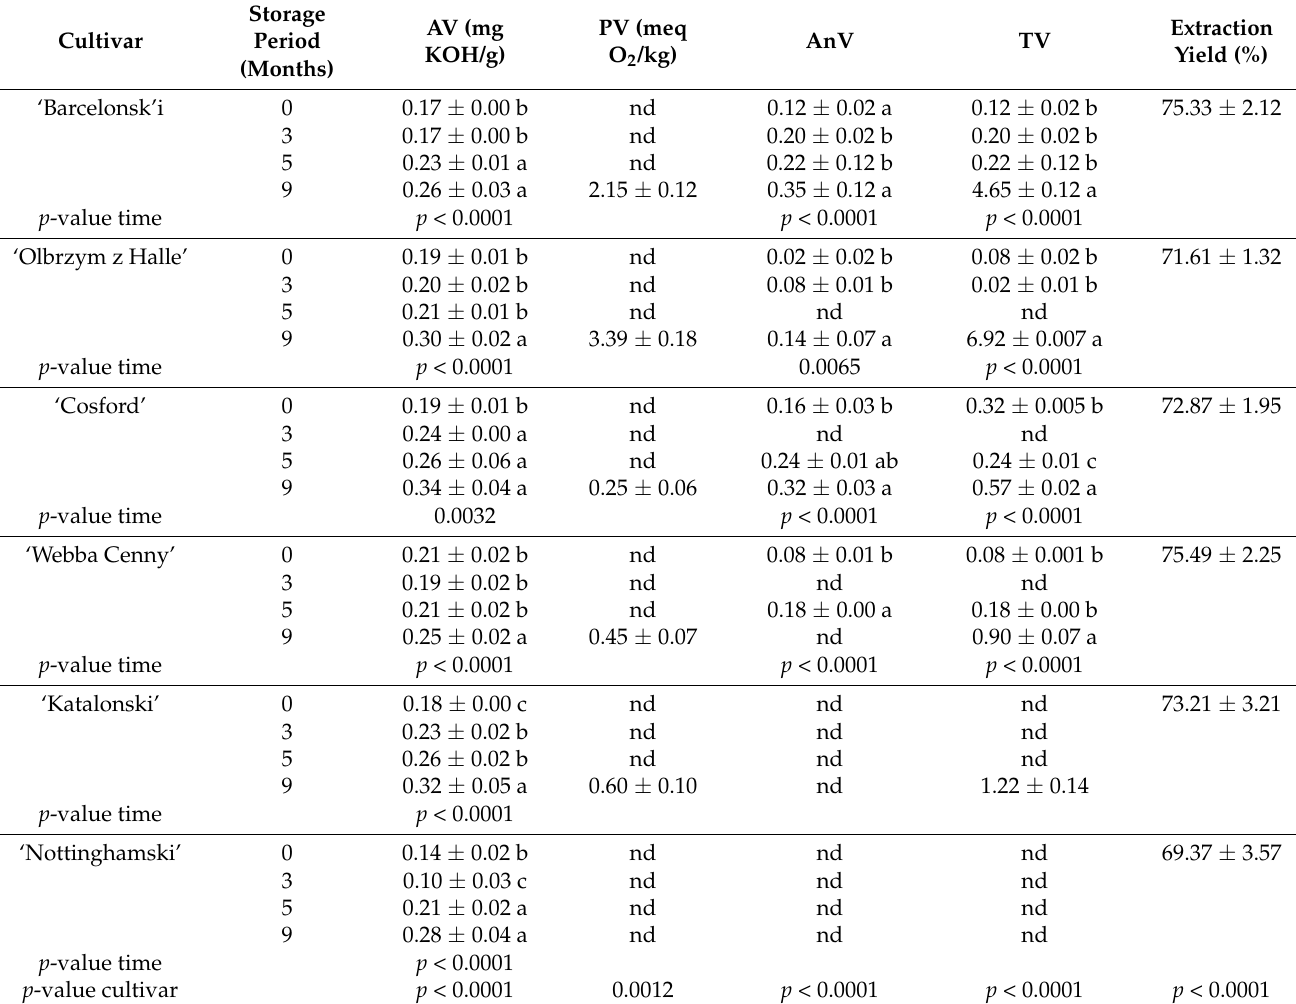
Table 1. Extraction yield and oxidation indices of cold-pressed hazelnut oil from six hazelnut cultivars during 9 months of